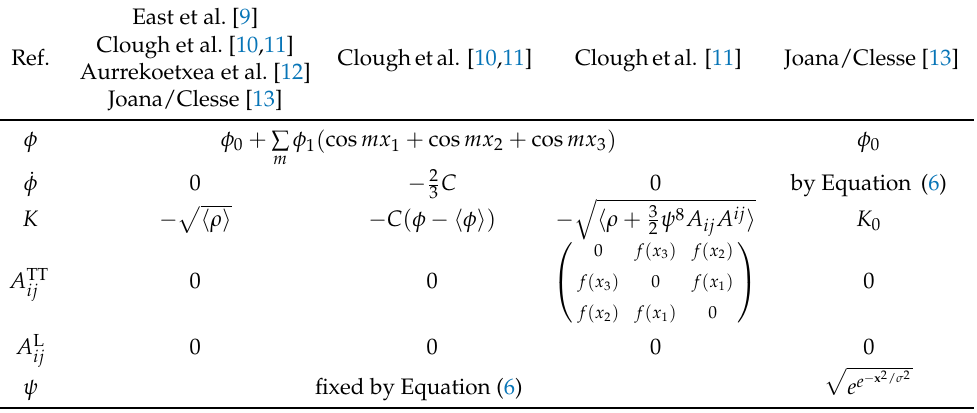
Table 2. Initial conditions in robustness studies of inflation to date determined by fixing only 6 or less parameters. The scalar field φ , its velocity ˙ φ , the mean curvature K , the transverse, traceless component A TT and the longitudinal component A L of the shear tensor A ij as well as the conformal ij ij factor ψ are specified at some initial time t 0 by fixing { φ 0 , φ 1 , C , M , A , m A } , where m , m A are integers ( ∂ ) 2 + V ( φ ) , (cid:104) (cid:105) denote averaging over m , L m A ≤ M , f ( x i ) = A cos ( m A x i ) , ρ = 1 with 1 ≤ L i φ 2 π 2 π 2 (cid:112) the spatial volume and K 0 = 24 ( Ψ + V ( φ 0 )) with Ψ being fixed through the conformal factor ψ only as defined in Equation (44) of Ref.